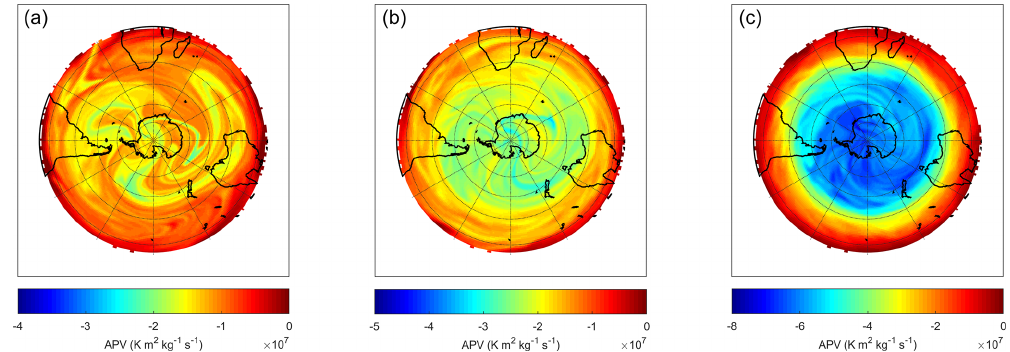
Figure 5. Advected potential vorticity (APV) maps from MIMOSA-CHIM at 425K (a) , 475K (b) and 600K (c) on 16 January 2012.